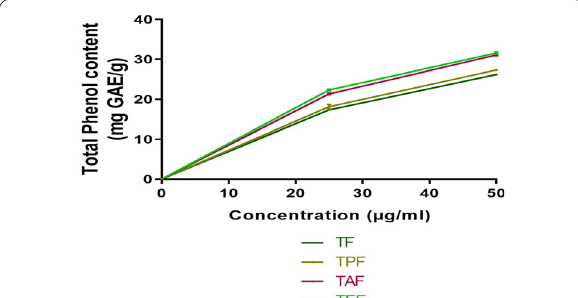
Fig. 2 The hydroxyl radicals (OH) of native and modified tacca flour. TF: Native tacca flour, TPF: tacca physical flour, TAF: tacca acetylated flour, TEF: tacca enzymatic starch